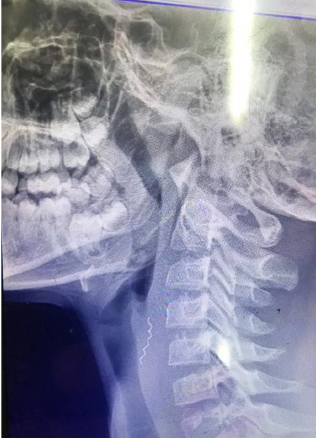
Figure 1. Lateral cervical x-ray shows a piece steel wool (arrow) in the hypopharynx region.